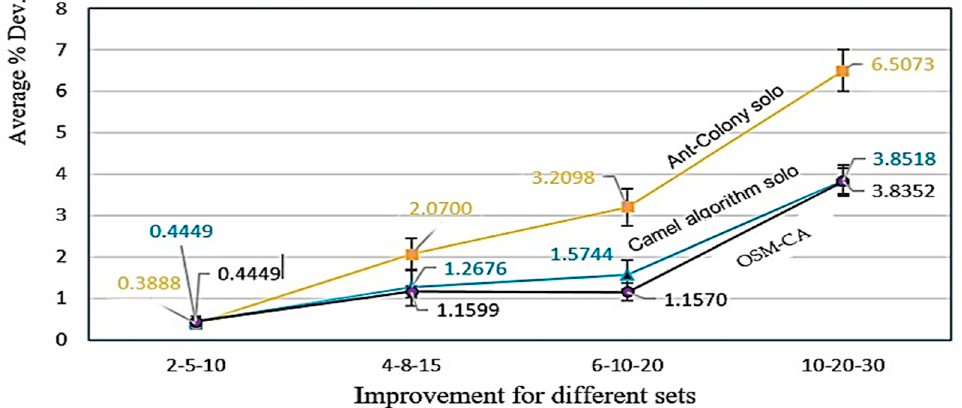
Figure 13. The deviation of proposed methodology OSM-CA and ACO, CA methods with Mathe- matical equation effect result.